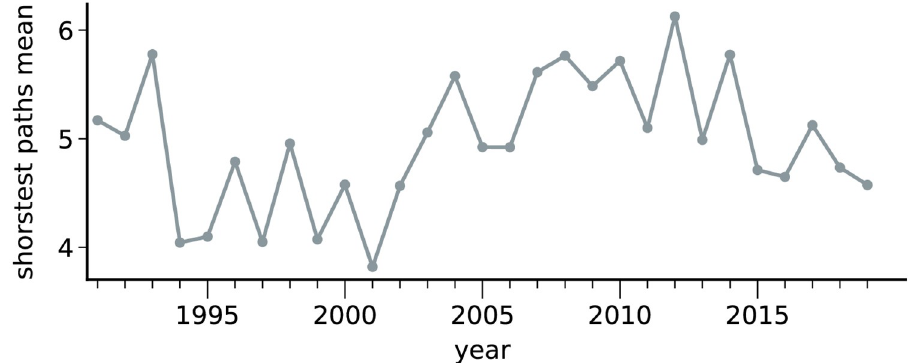
Fig 6. Evolution of the average shortest path length. While the average distance ranges in the interval 4 � d G � 6, the networks obtained in the interval between 1994 and 2002 are typically more cohesive than the ones obtained between 2003 and 2012.